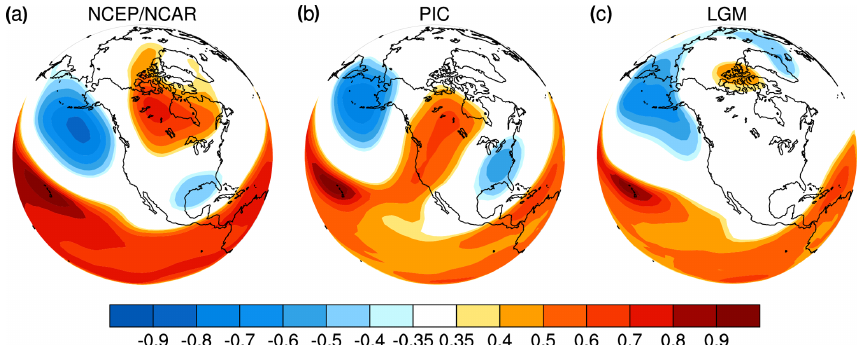
Figure 1. One-point correlation maps of 500hPa geopotential heights in DJF from NCEP/NCAR reanalysis and PMIP2 CCSM3 simulations. (a) NCEP/NCAR, (b) PIC and (c) LGM. The base point is near Hawaii. The correlation coefficient of 0.35 corresponds to the 95% confidence level for 30-year